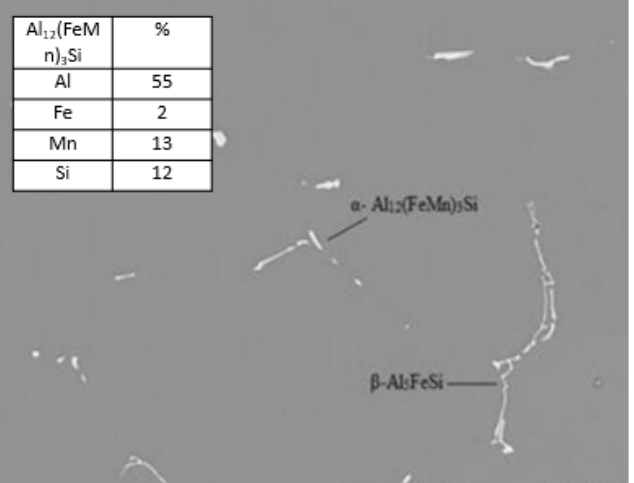
Figure 3. MEB micrography of a sample of alloy A6063 made of recycled aluminium, with heat treatment homogenized to 848 ᵒ K for 480 minutes and semi-quantitative analysis. treatment homogenized to 848 K for 480 min and semi-quantitative